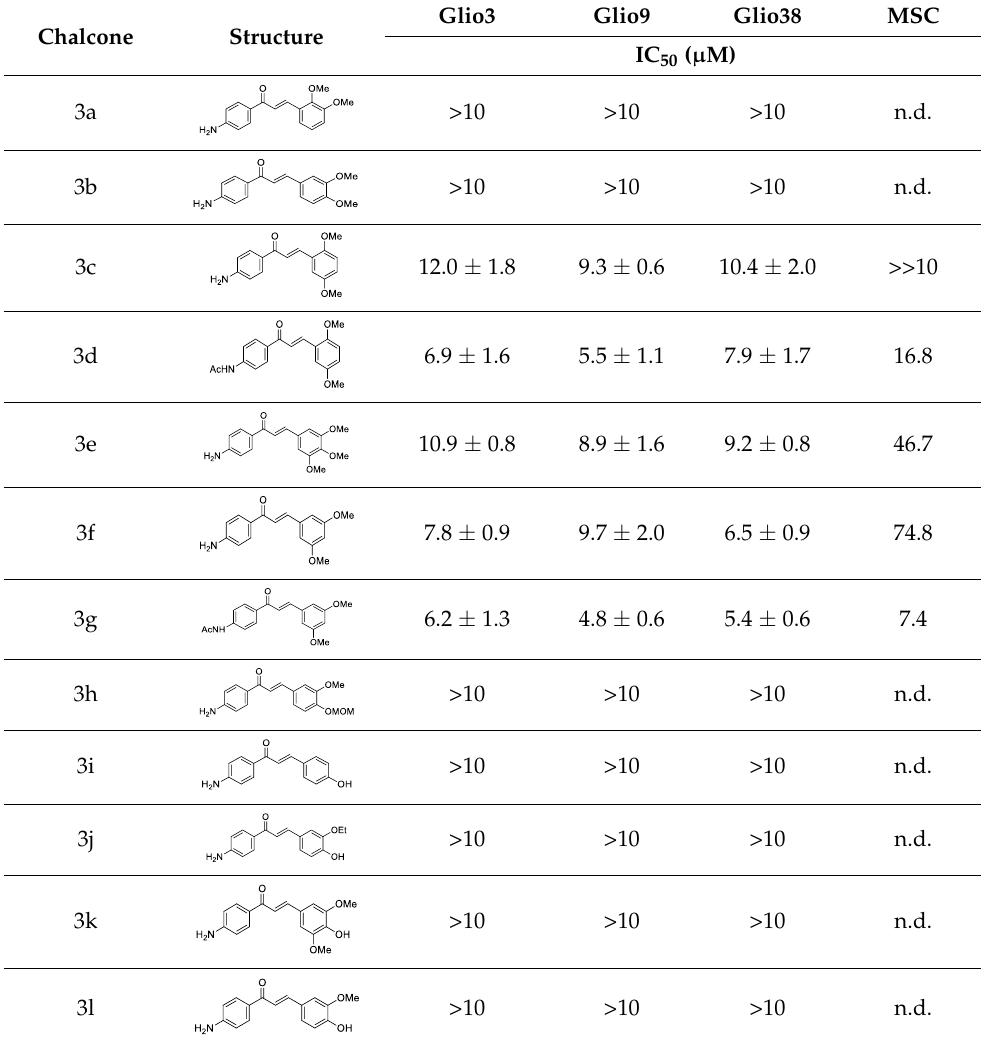
Table 1. IC 50 of 4′ -aminoacetophenone chalcone derivatives.